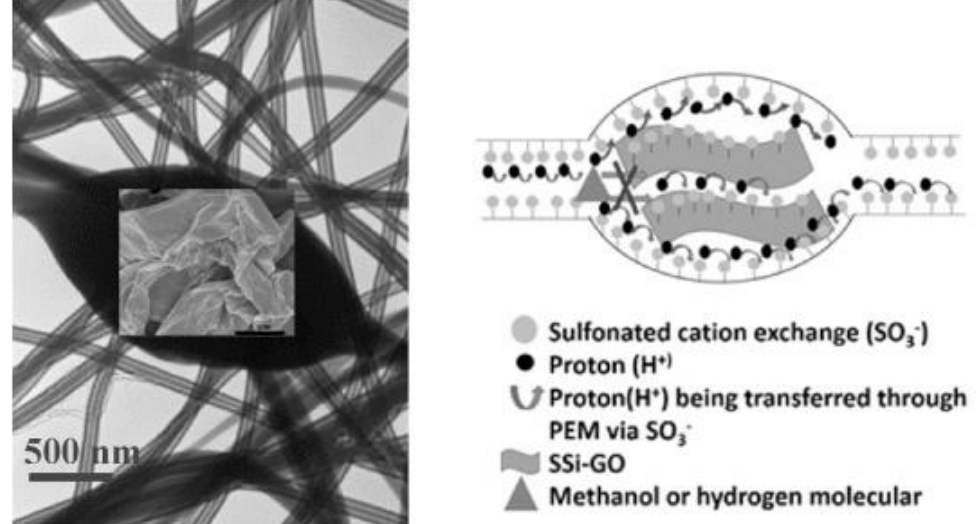
Figure 2. TEM image of a co-spinning sulfonated organosilane graphene oxide (SSi-GO)/SPEEK and aschematic representation of methanol and hydrogen diffusion through the cambiform-like structure of the core-shell nanofibers [33].